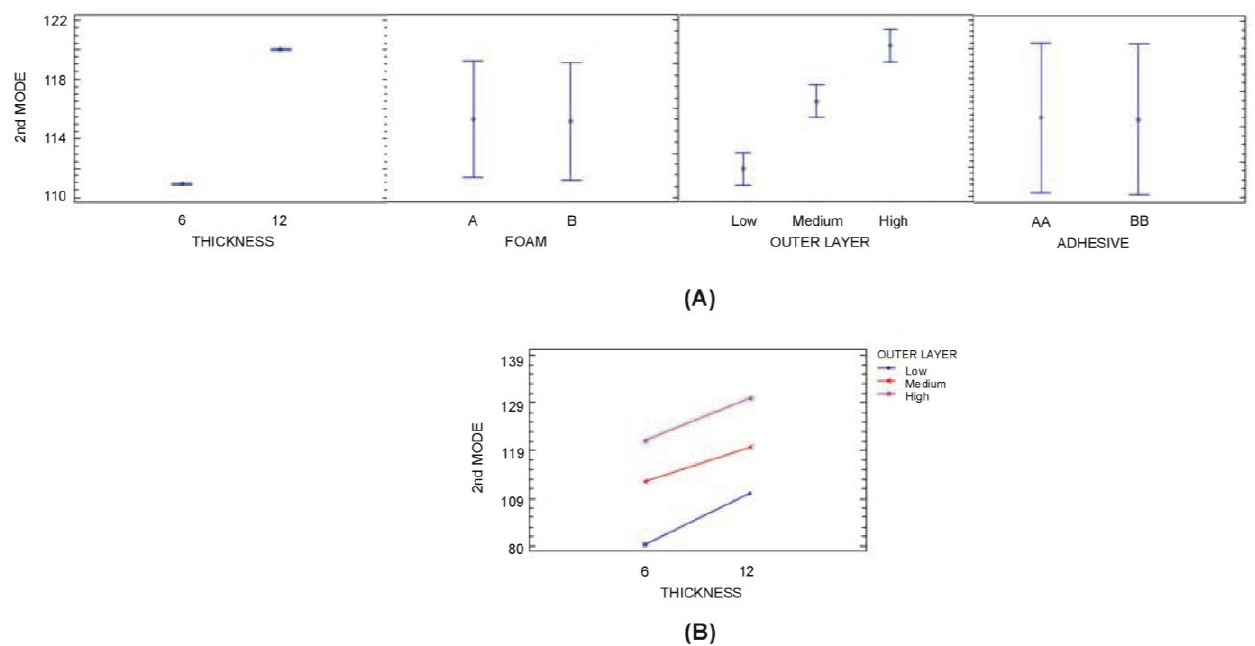
Figure 11. ( a ) 2nd Mode (95% confidence interval ( b ) 2nd Mode: A × C interaction (95% confidence interval).